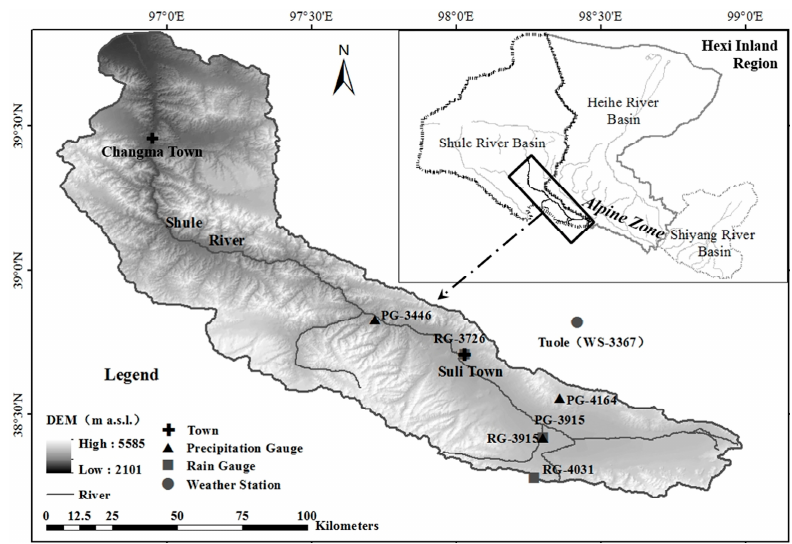
Figure 1. Precipitation observing sites in the upper reaches of the Shule River.